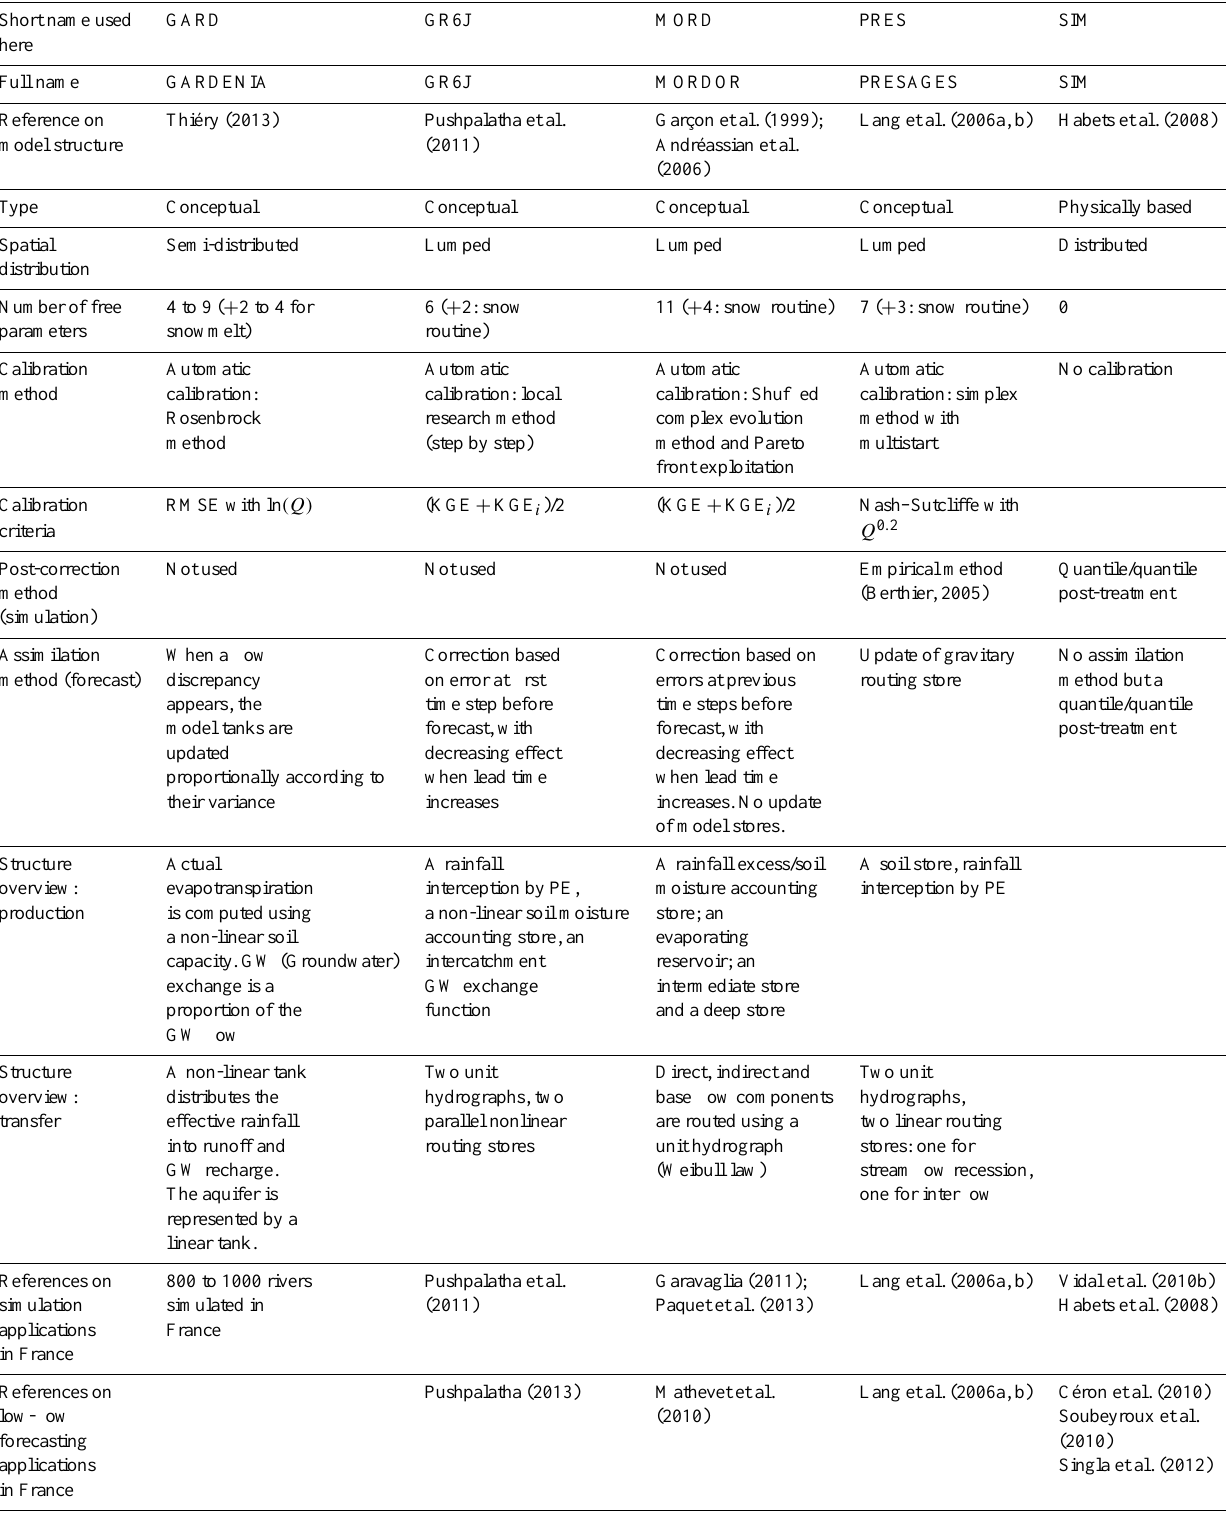
Table 3. Overview of the characteristics of the five models